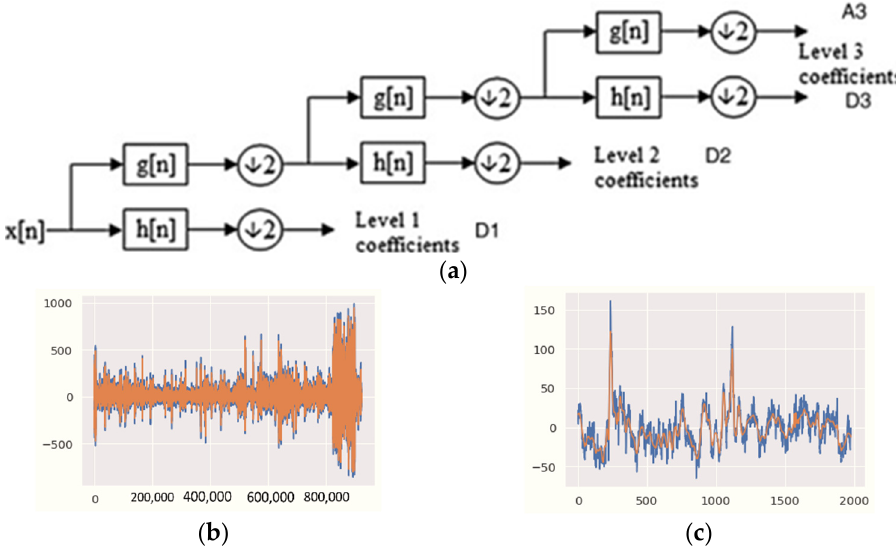
Figure 3. ( a ) Decomposition of signal using DWT with different levels. ( b ) Large scale and ( c ) small scale. ( b , c ) Illustrates the effect of noise cleaning, where the blue signal is the signal before removing noise and the orange signal is the signal after applying the most suitable de-noising technique, according to RMSE and SNR.